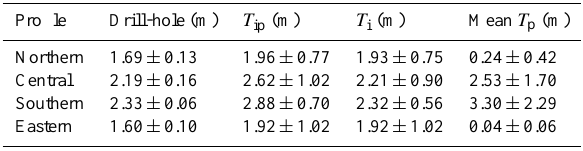
Table 1. The mean of all drill-hole measurements used along the profiles ( n = 20) of 2.00 ± 0.31 corresponds better to a surface ele- vation derived sea ice thickness accounting for the sub-ice platelet layer ( T i ) of 2.11 ± 0.85m, than one in which it is ignored ( T ip ) giving 2.39 ±